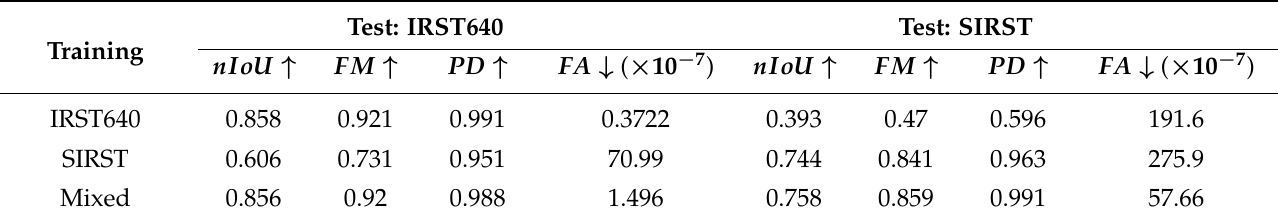
Table 9. Results of different training